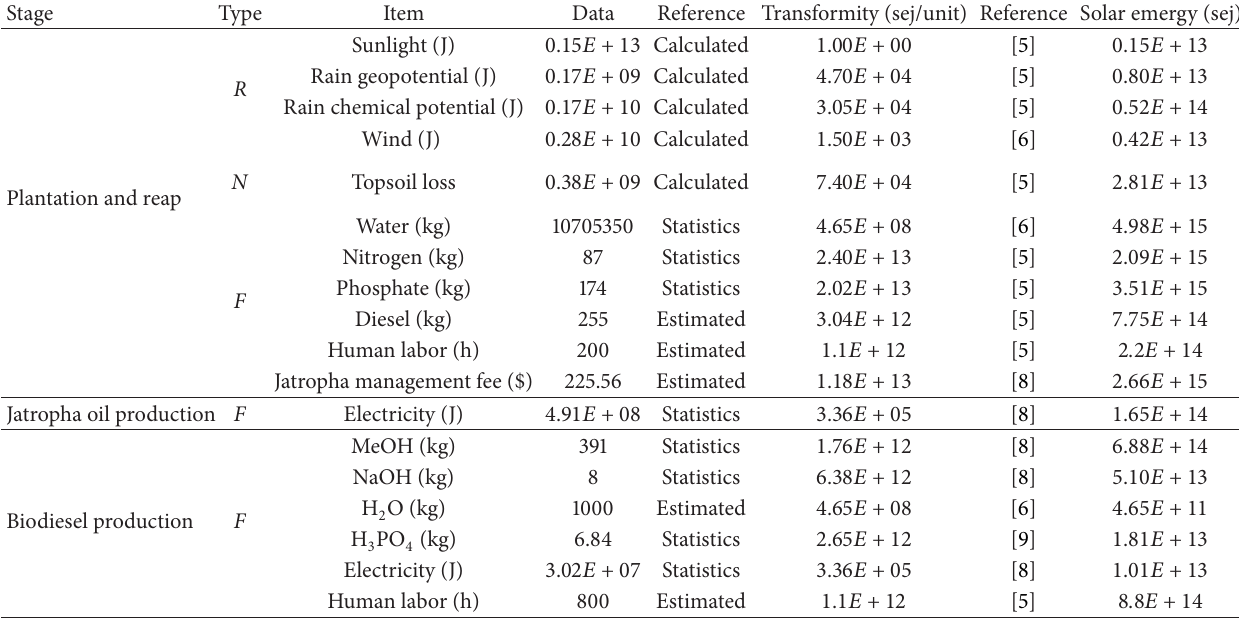
Table 7: Emergy analysis table for jatropha-based